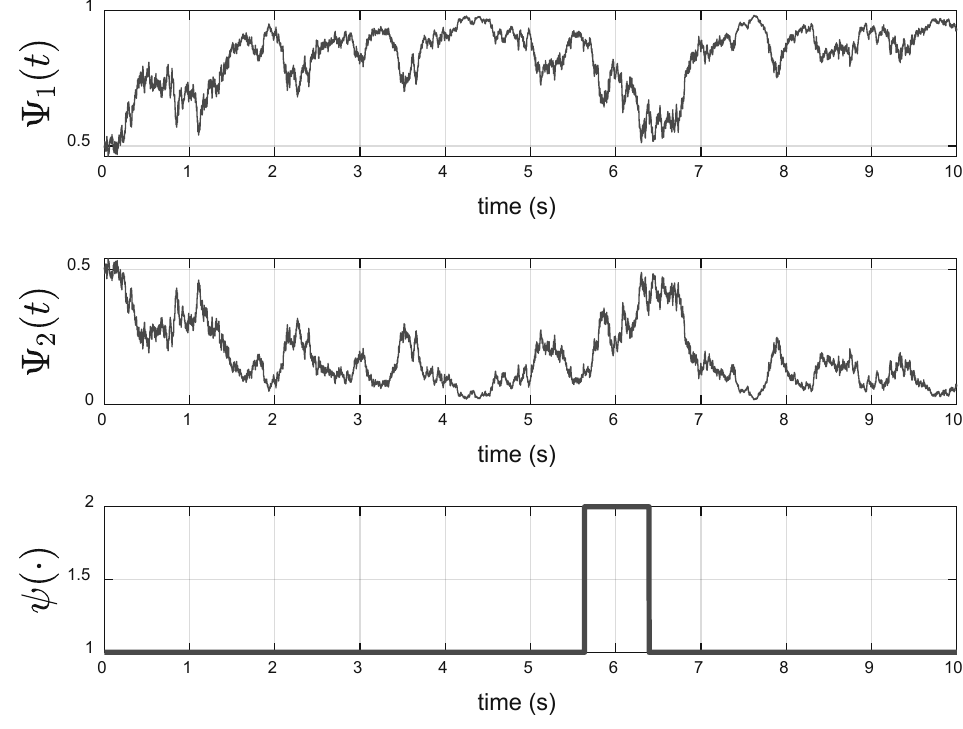
Figure 4. Wonham filter and hidden Markov chain (in t = 1 s). The asymptotic behavior of the optimal control (55) is given in Figure 5